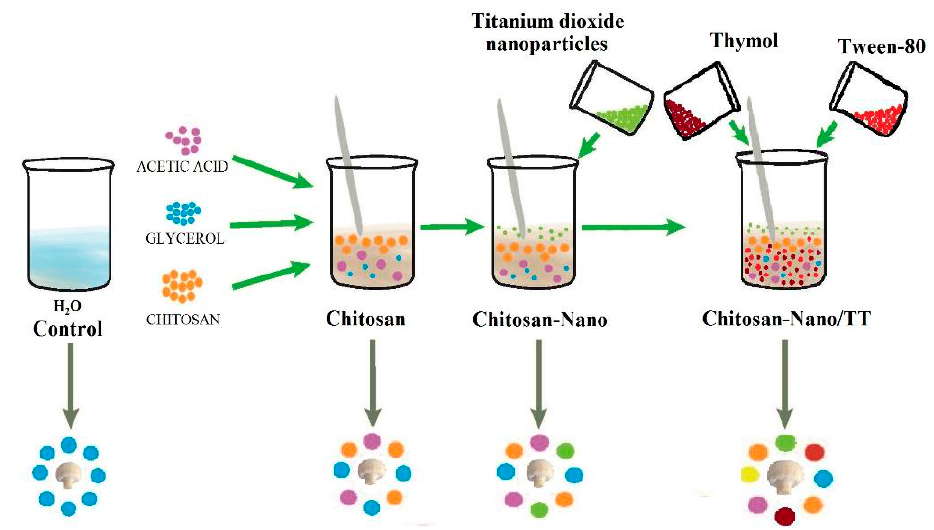
Figure 1. Film preparation and mushroom treatments.